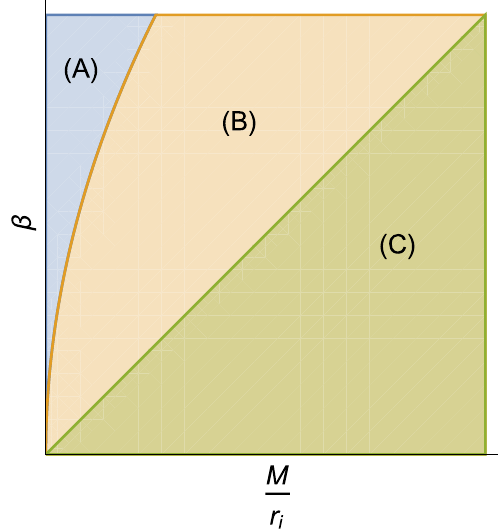
(cid:19) M / r s , d , and (B)